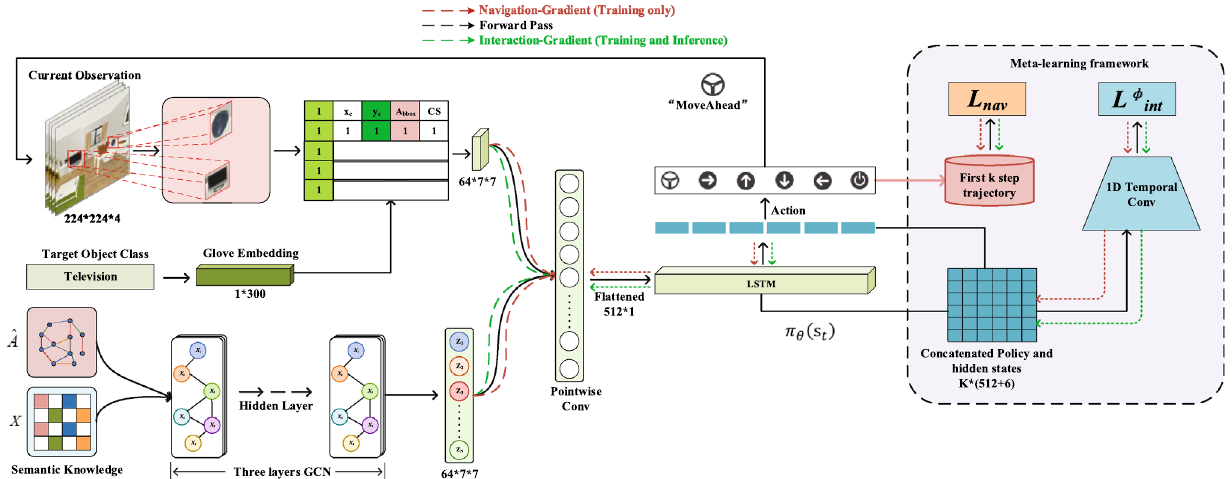
Fig. 2 Model overview. Our visual mapless navigation model involves a visual representation learning and navigation policy learning. We first joint the hierarchical relationships represented by context vector of cur-